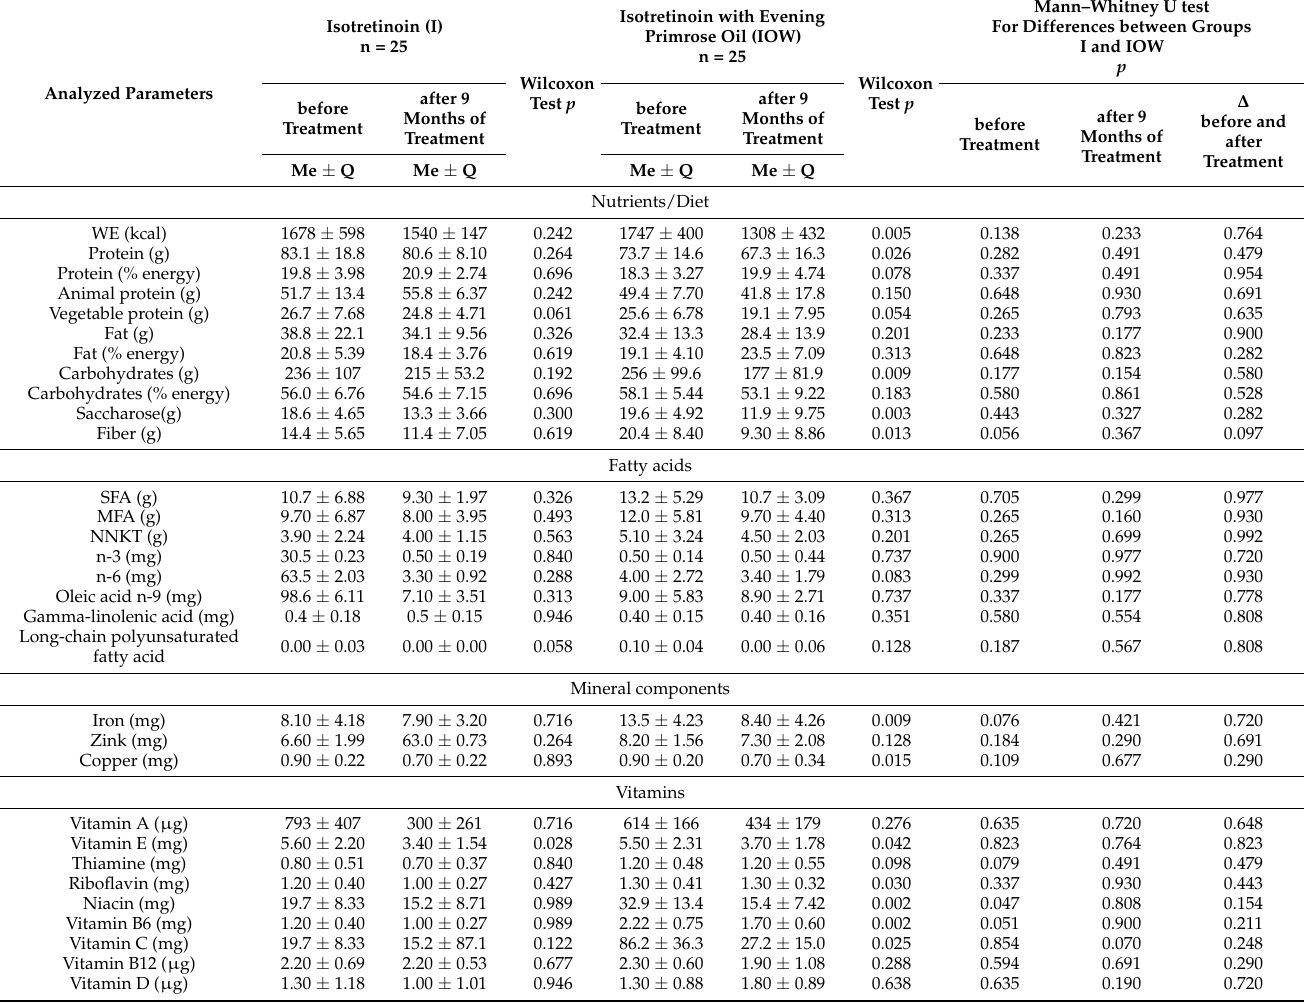
Table 5. Content of analyzed nutrients in whole daily rations of the study group before and